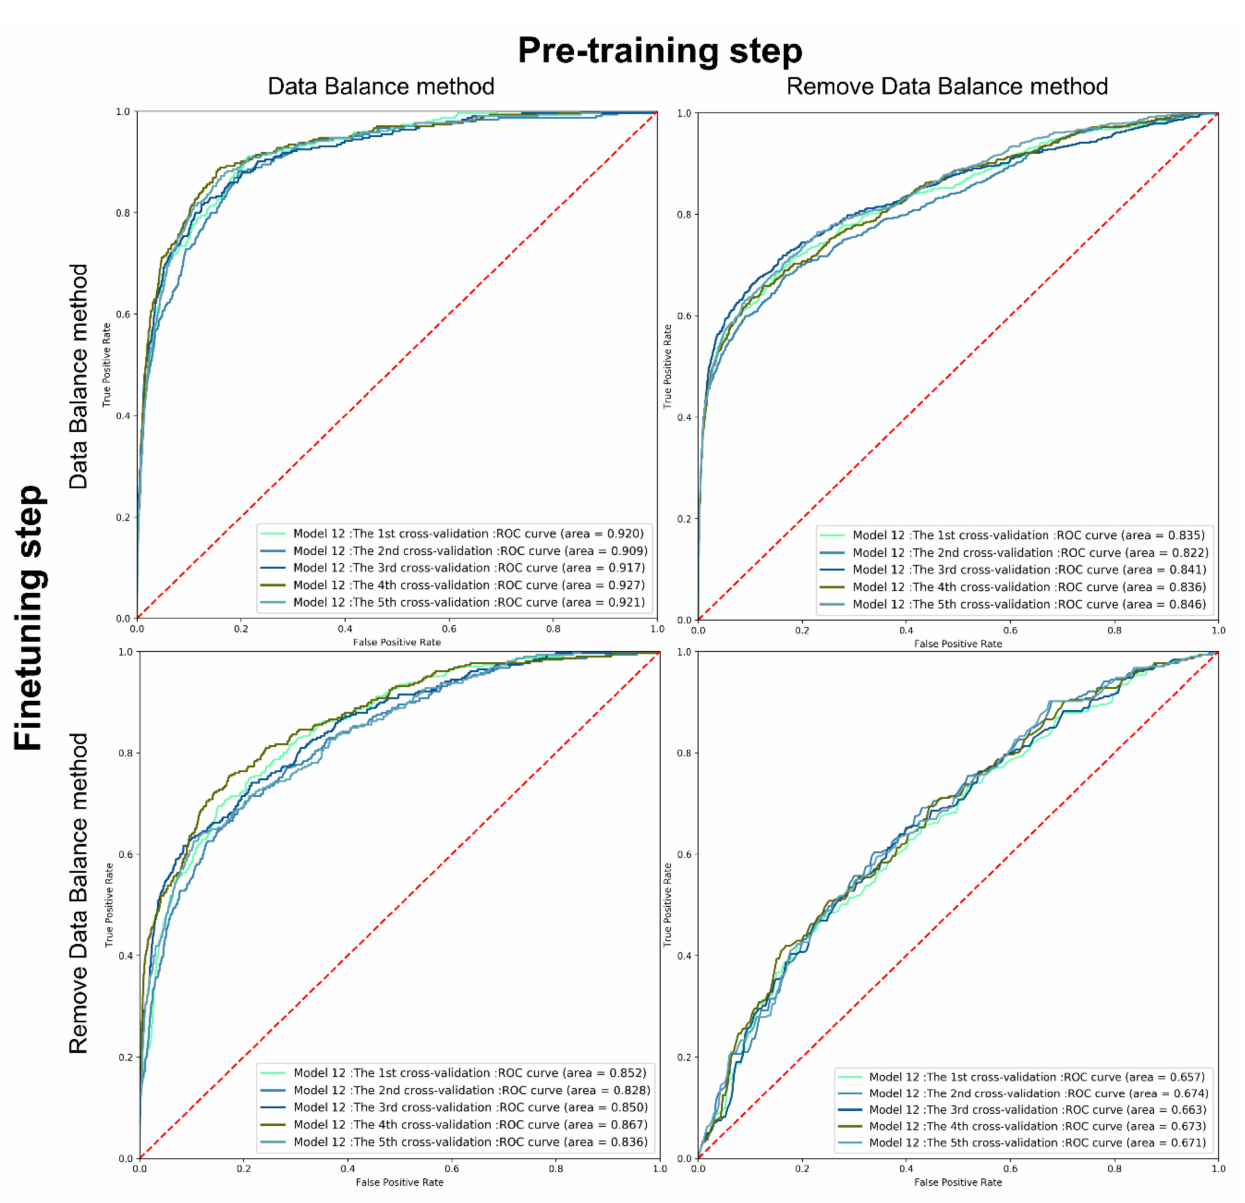
Figure 6. AUROC curve of models removing the data balancing method in the pre-training and fine-tuning